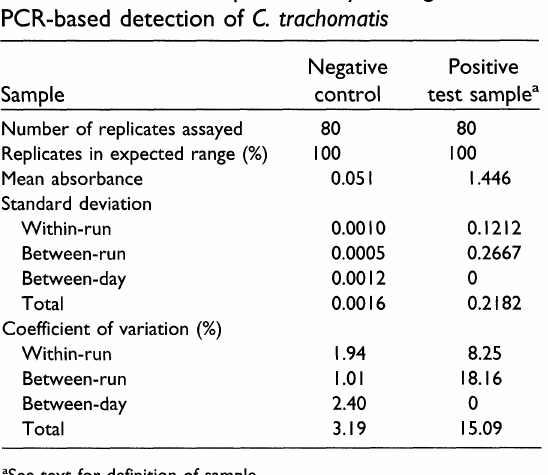
TABLE I. Results of reproducibility testing of PCR-based detection of C.